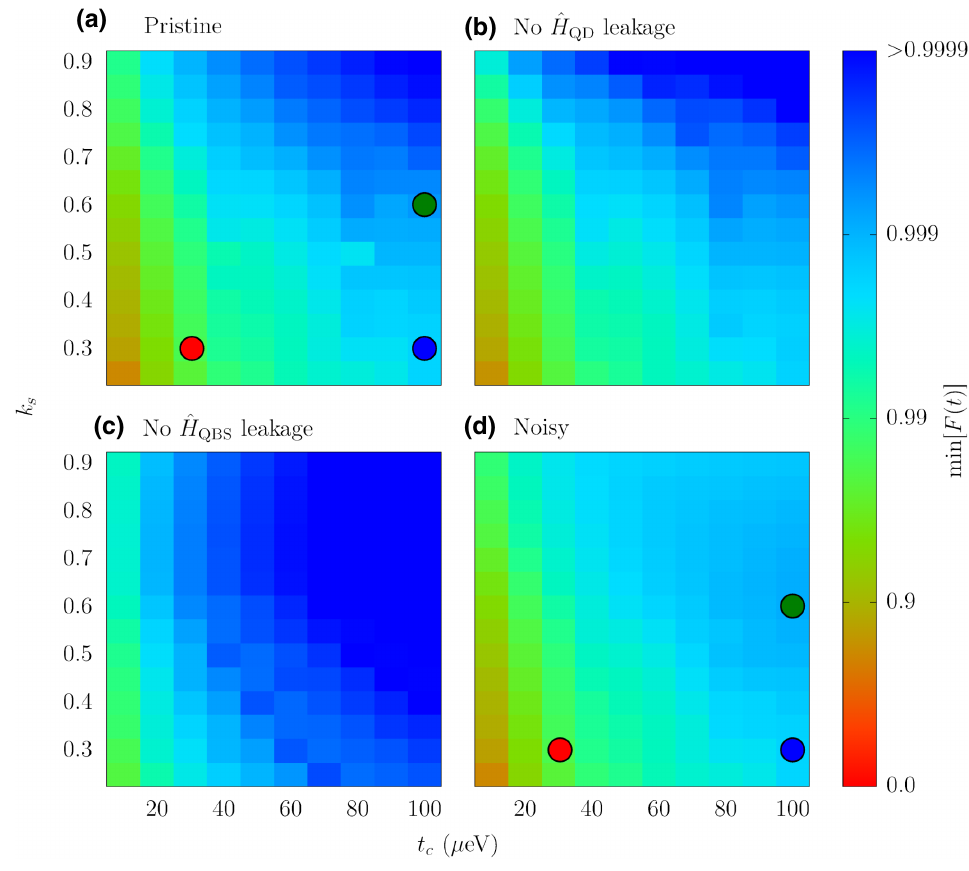
FIG. 4. The accuracy of the simulator for different sensitivities k s and tunnel couplings t c . The plots show heat maps of the minimum fidelity [Eq. (40)] throughout the simulation period min[ F ( t ) ] for simulators (a) in pristine form and (b),(c) without coupling to spectator states ( | S 1 (cid:2) , | T + (cid:2) , | T 0 (cid:2) ) through either (b) the QD Hamiltonian ˆ H QD [Eq. (21)] or (c) the QD-QBS interaction ˆ H QD-QBS [Eq. (27)]. (d) Quantification of the simulation accuracy in the presence of electrical noise σ (cid:2) = 2 μ eV added to the detuning (cid:2) d . The color map is based on a logarithmic